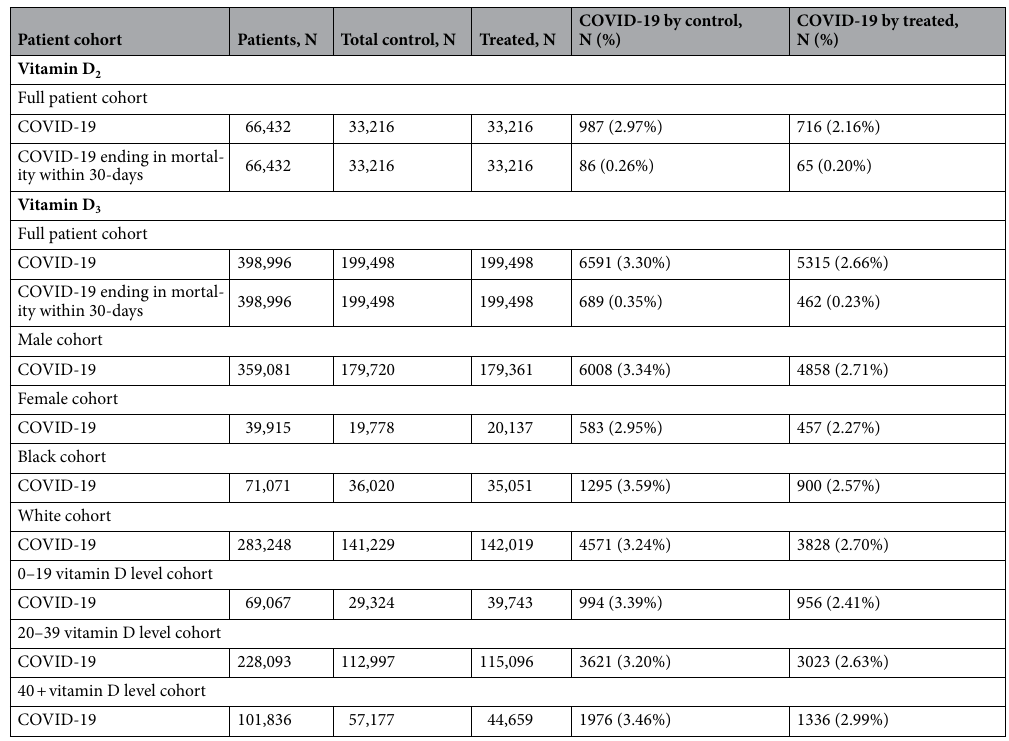
Table 2. COVID-19 frequencies by patient cohort after 1–1 propensity score